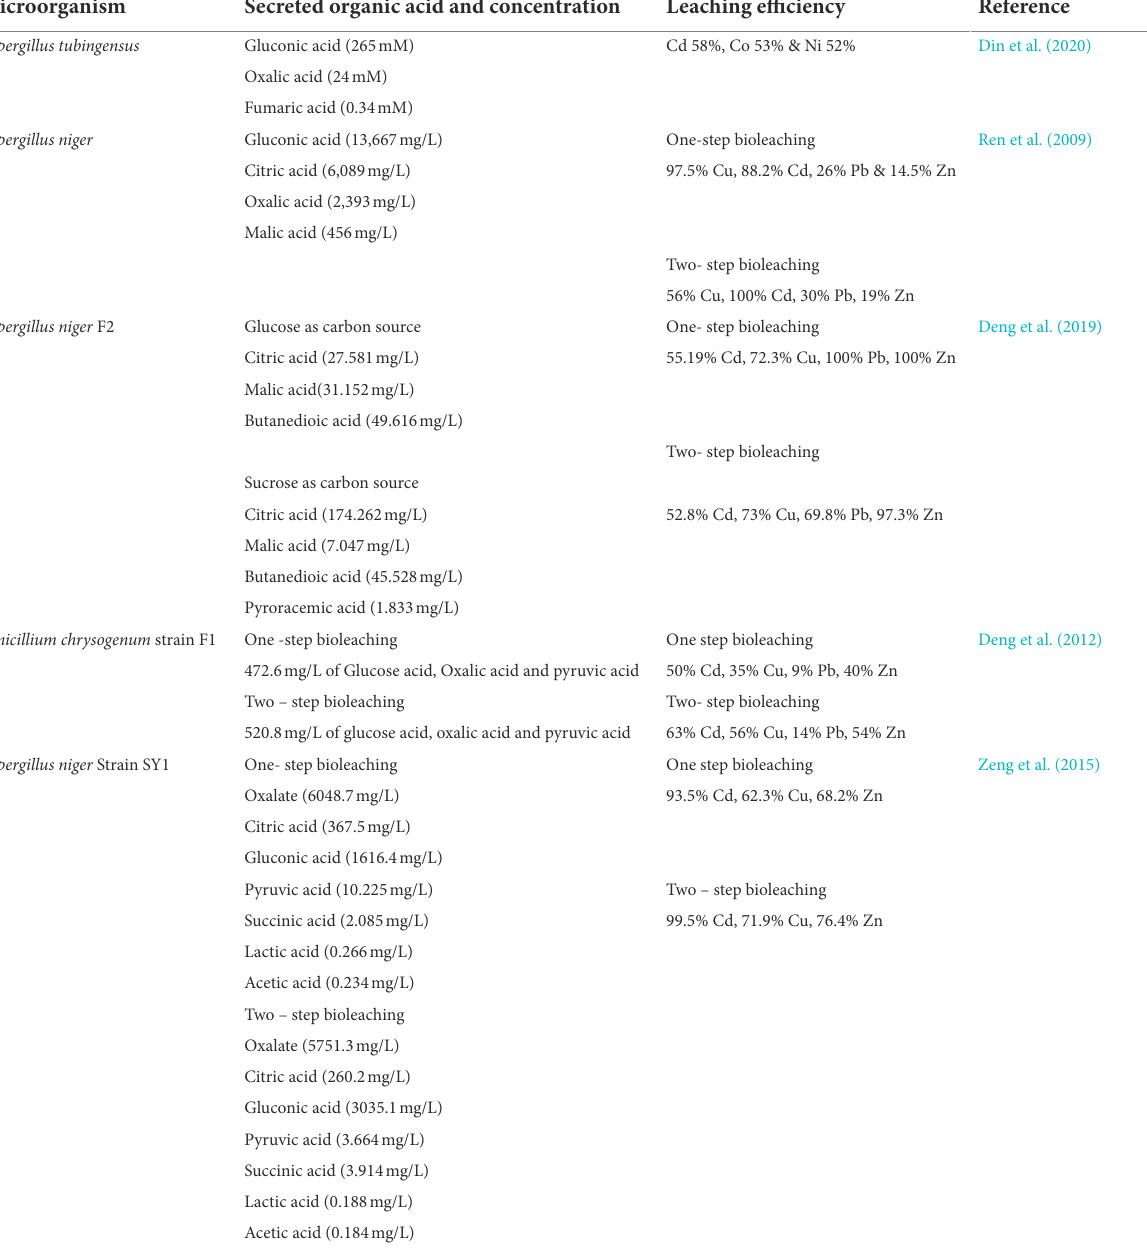
TABLE 2 Organic acids secretion and concentration by microorganism and their leaching